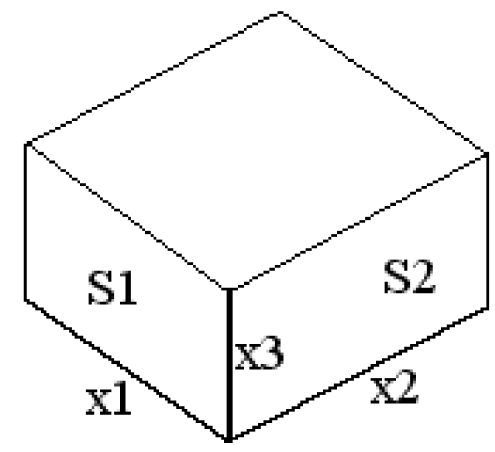
Fig. 2. Rectangular surfaces S 1 and S 2 (measurands).